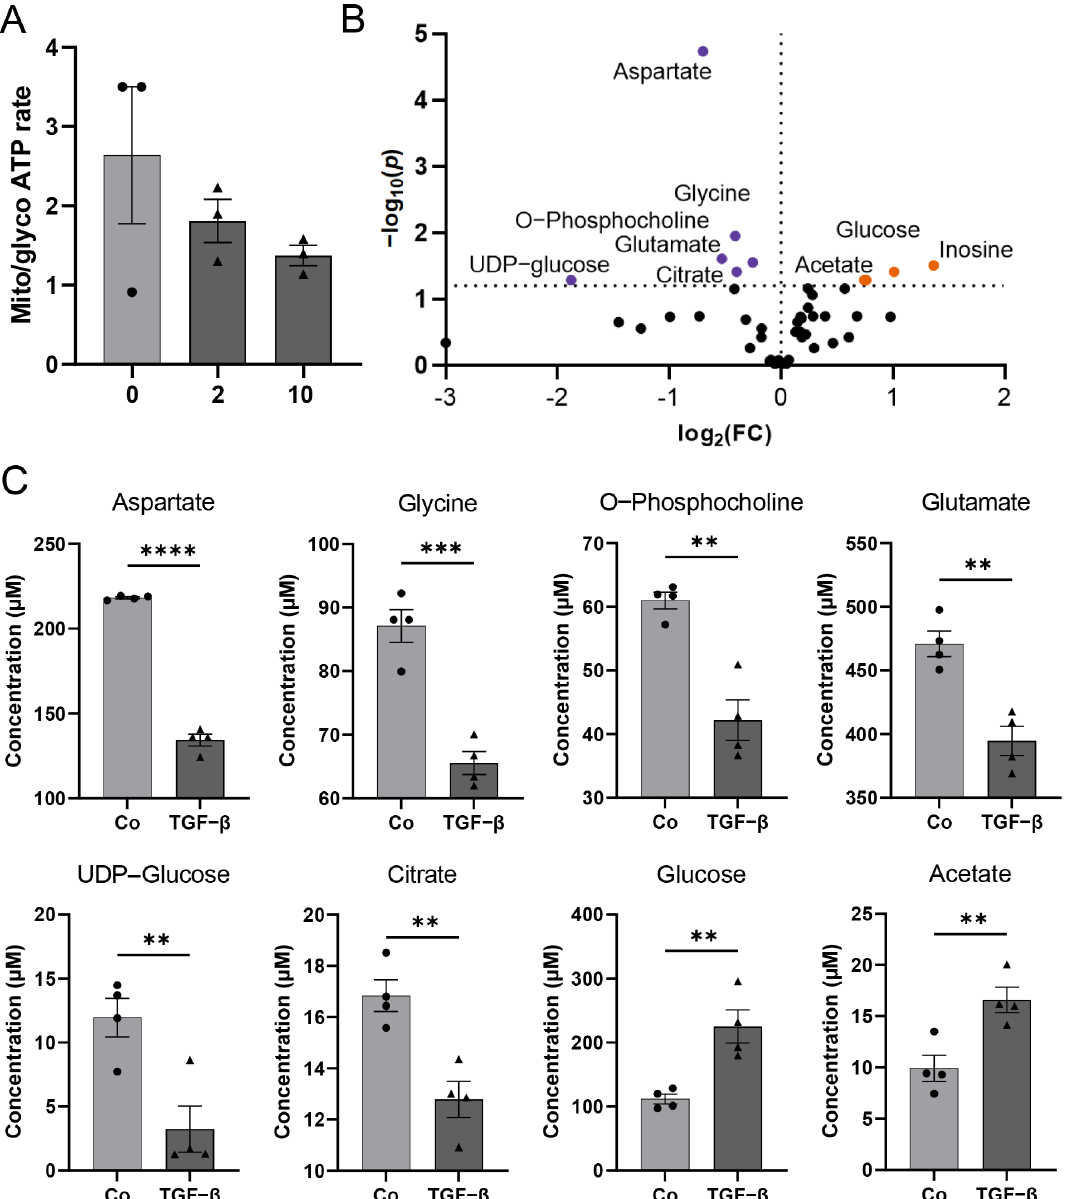
Figure 4. Metabolomics analysis of HBVP upon TGF- β treatment. ( A ) Determination of mitochondrial to glycolytic ATP production at different TGF- β concentrations using respiratory analysis. HBVP were treated with TGF- β (2 or 10 ng/mL, dark grey bars; black triangles) for 16 h or were left untreated (0; light grey bar; black dots; n = 3, each 6 technical replicates, SEM). ( B ) Volcano plot visualizing most significant metabolite concentration increase (orange dots) and decrease (purple dots) upon TGF- β treatment compared to control for p < 0.05, false discovery rate (FDR)-corrected data with fold change (FC) threshold >1.2 ( n = 4). ( C ) Bar plots with individual replicate points and SEM of the most significant metabolite changes upon TGF- β treatment (each 5 ng/mL of TGF- β 1 plus β 2; black triangles) ( n = 4): aspartate, glycine, O-phosphocholine, glutamate, UDP-glucose, and citrate concentrations were decreased compared to control (black dots), while glucose and acetate concentrations increased upon TGF- β treatment, based on parametric, unpaired t -test, ** p < 0.01, *** p < 0.001, **** p < 0.0001. Grey bar and circles present controls, dark grey bars and squares present the TGF- β